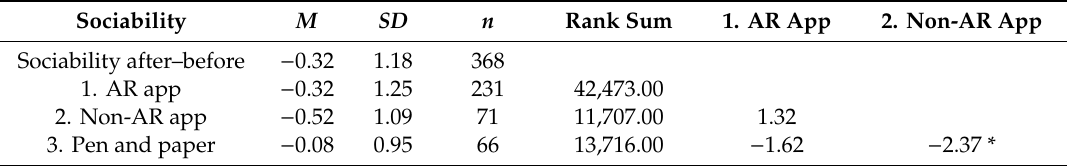
Table 2. Means ( M ), Standard Deviations ( SD ), Frequencies ( n ), Rank Sum, and Dunn’s Multiple Nonparametric Pairwise Post Hoc Test with Bonferroni Corrections for Di ff erences in Dependent Variable of Sociability ( N = 372).